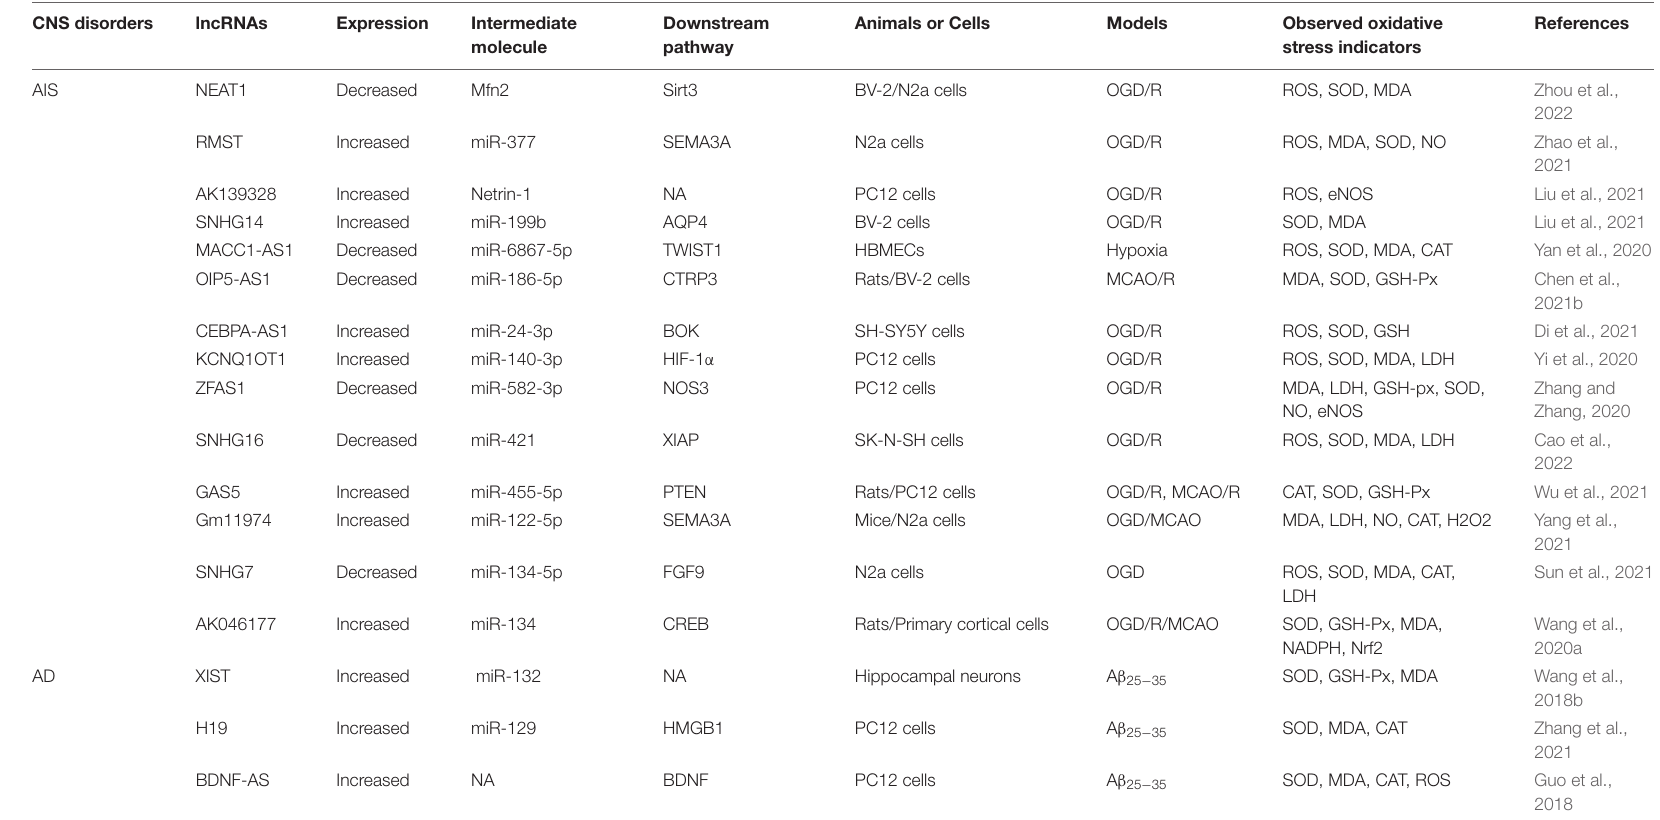
TABLE 1 | The molecular targets, downstream pathways and oxidative stress regulation of lncRNAs in central nervous system (CNS)